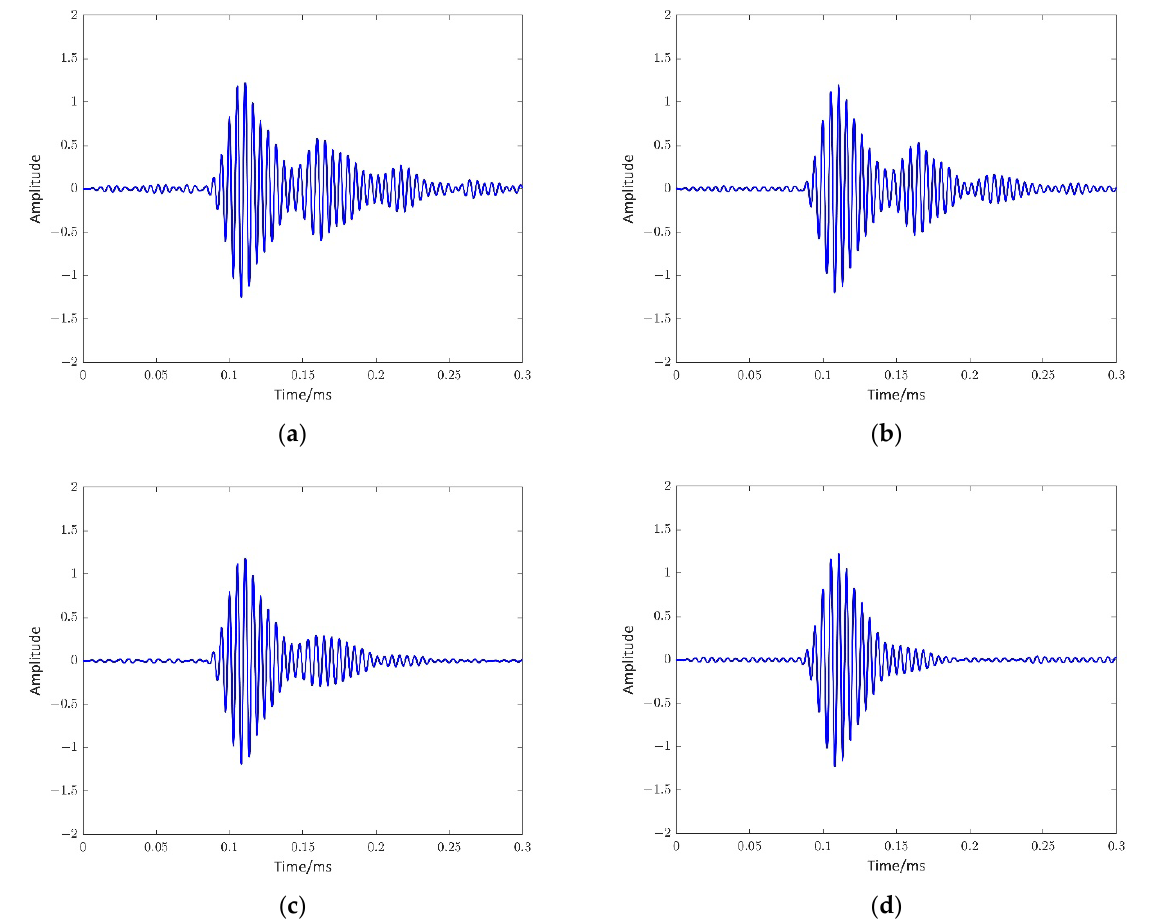
Figure 9. Time domain waveform of reflected signals under different electrolytic voltages measured experimentally. The voltage is 0 V, 6 V, 7 V and 8 V, respectively, in figure ( a ), ( b ), ( c ), and ( d ).